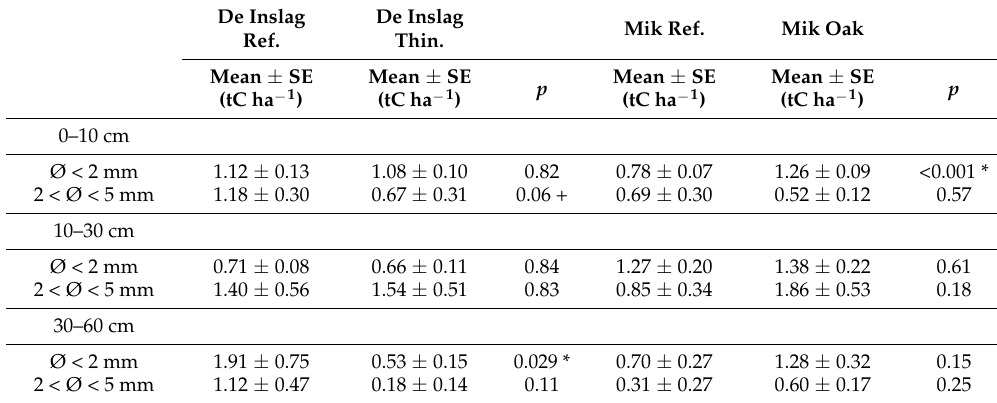
Table 3. Mean values of C stocks (tC ha − 1 ) with standard error (SE; tC ha − 1 ) of the fine (with less than 2 mm in diameter) and medium roots (with diameter between 2 and 5 mm) in different soil layers at the study stands. The star (*) indicates a statistically significant difference between stands at p < 0.05, the plus (+) indicates 0.05 < p < 0.10. De Inslag De Inslag Mik Ref. Mik Oak Ref. Thin. Mean ± SE Mean ± SE Mean ± SE p (tC ha − 1 ) (tC ha − 1 ) (tC ha − 1 )